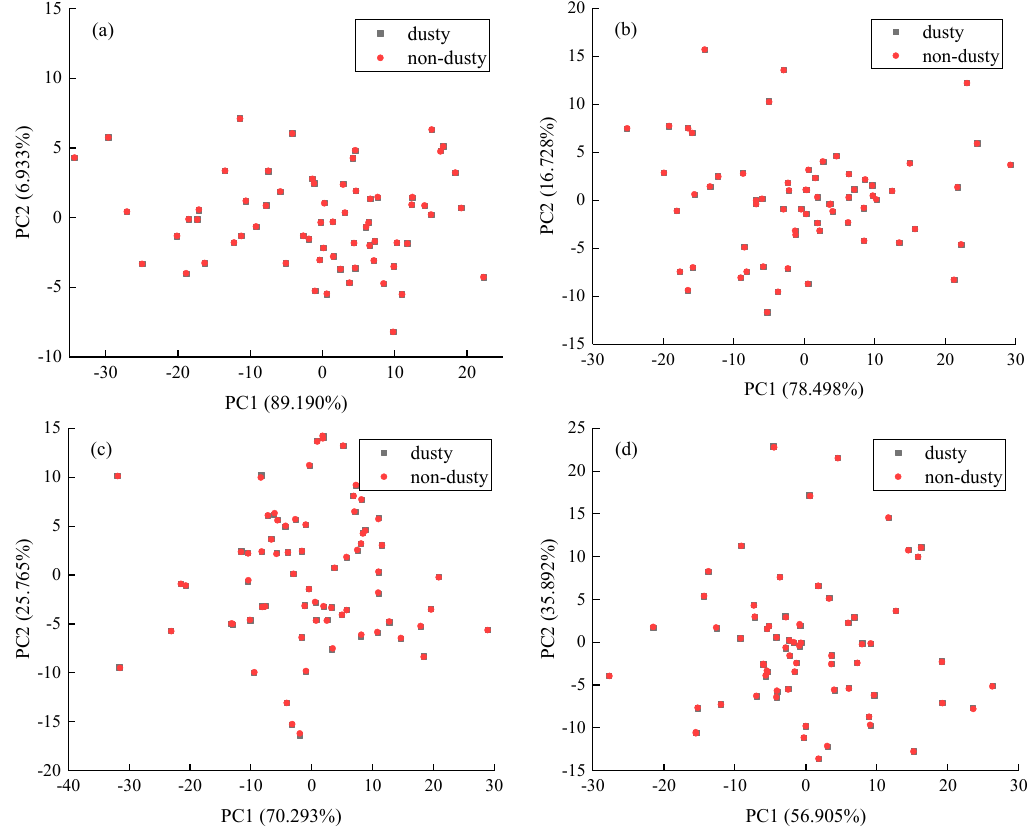
Figure 4. Bi-plot for the spectra of dusty and non-dusty leaves based on the studied characters. (a) Leymus chinensis , (b) Cleistogenes squarrosa , (c) Potentilla acaulis, (d) Scutellaria scordifolia.